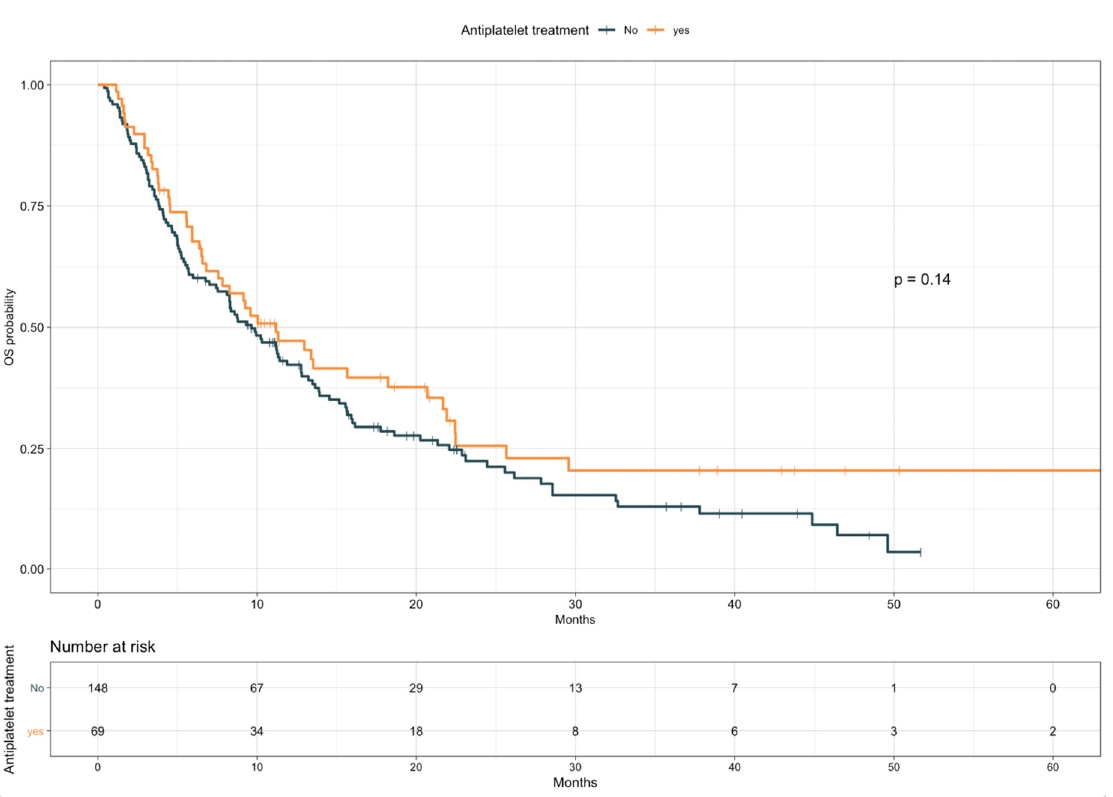
Figure 3. Overall survival according to antiplatelet treatment. Table 6. Multivariate Cox proportional hazards models for overall survival.